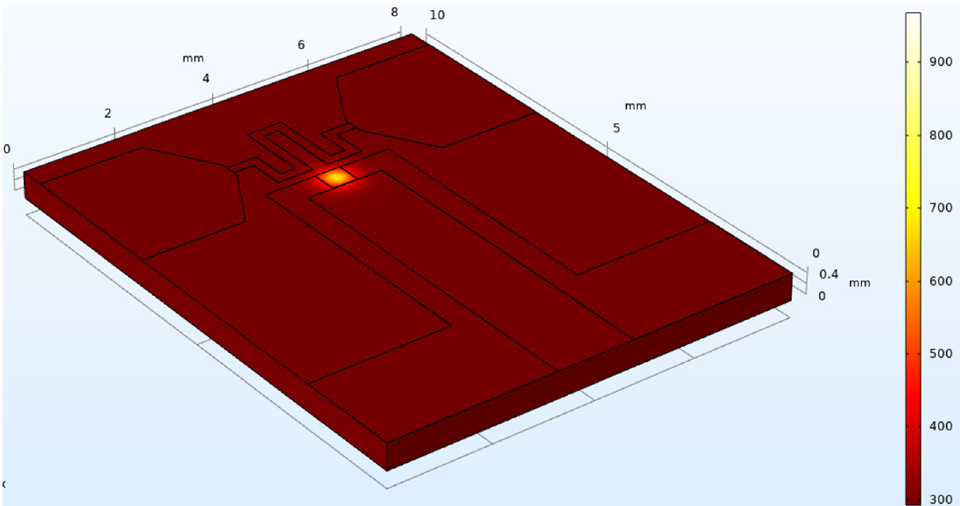
Figure 2. The temperature distribution of thermocouple is simulated by Comsol software.